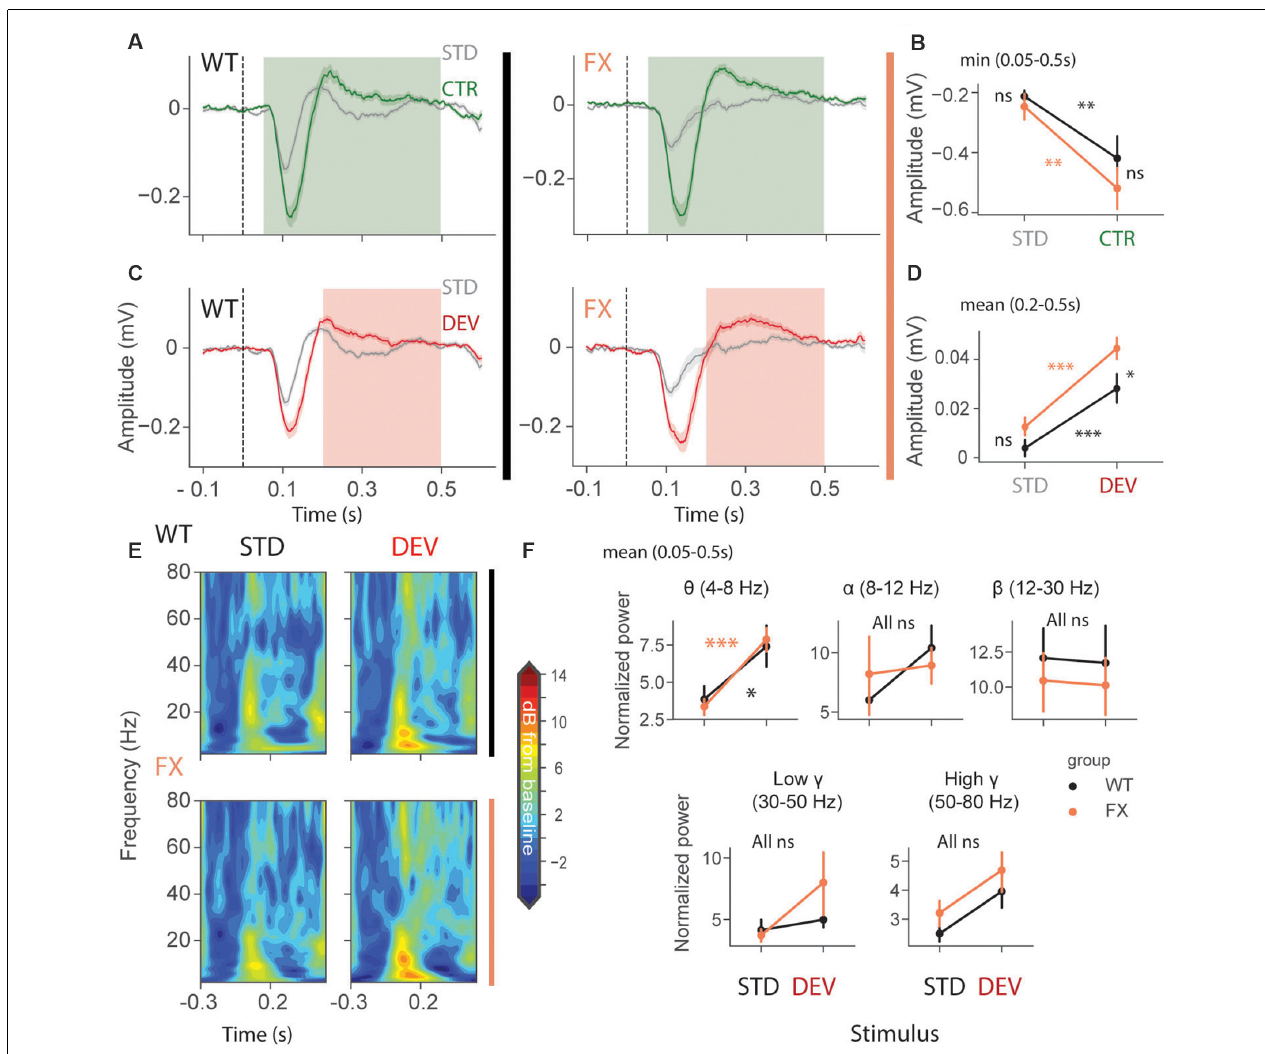
FIGURE 2 | Enhanced late responses in L4 of FX mice during a visual oddball paradigm. (A) Averaged layer 4 LFP traces in response to STD and CTR stimuli for WT (left) and FX (right) from cortical layer 4. (B) The point plots show the mean and s.e.m. of the strongest negative deflection within 0.05–0.5 s relative to the stimulus onset. (C) Same as in (A) but comparing STD vs. DEV. (D) Same as in (B) , but responses were averaged within 0.2–0.5 s. (E) Time-frequency spectra of the L4 LFP traces of WT (top) and FX (bottom). (F) Point plots show the mean power within 0.05–0.5 s relative to the stimulus onset across different frequency bands. ∗ p < 0.05, ∗∗ p < 0.01, ∗∗∗ p < 0.001, ns = not significant.